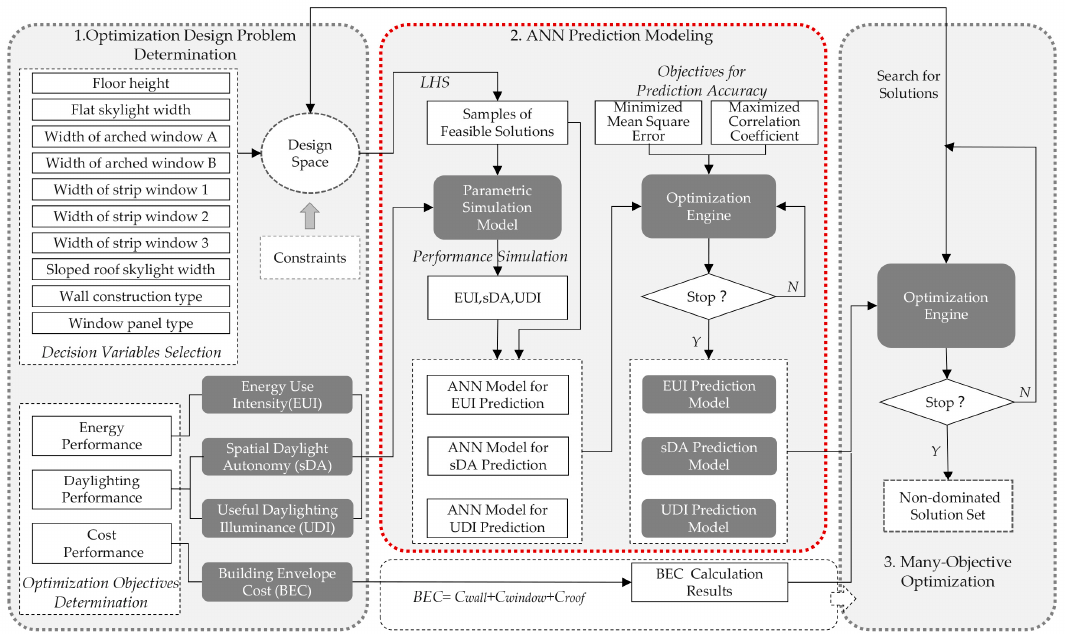
Figure 1. Artificial Neural Network (ANN) based many-objective optimization design workflow.